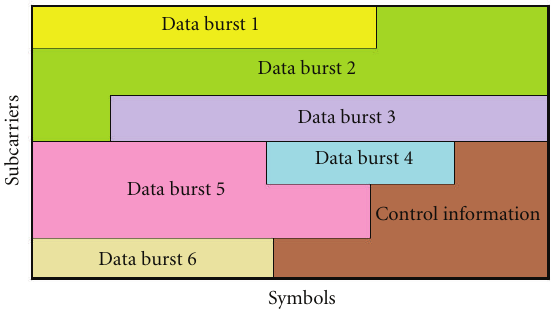
Figure 2: Rough schematic of OFDM frame in